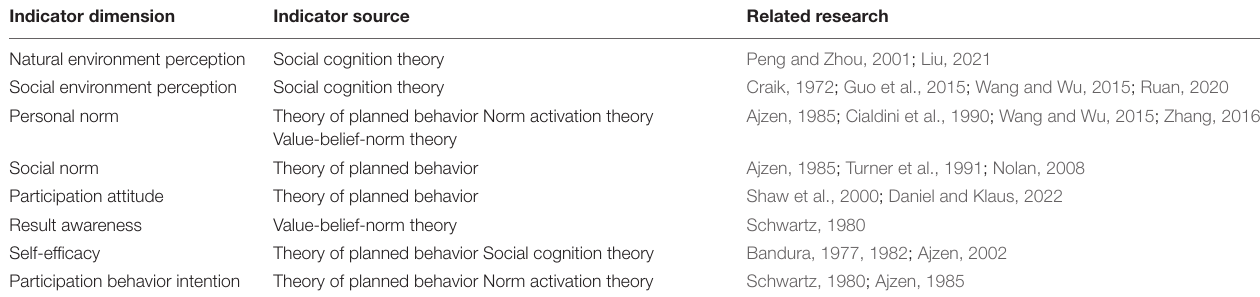
FIGURE 1 | Integrated theoretical framework. TABLE 2 | Metric sources for research